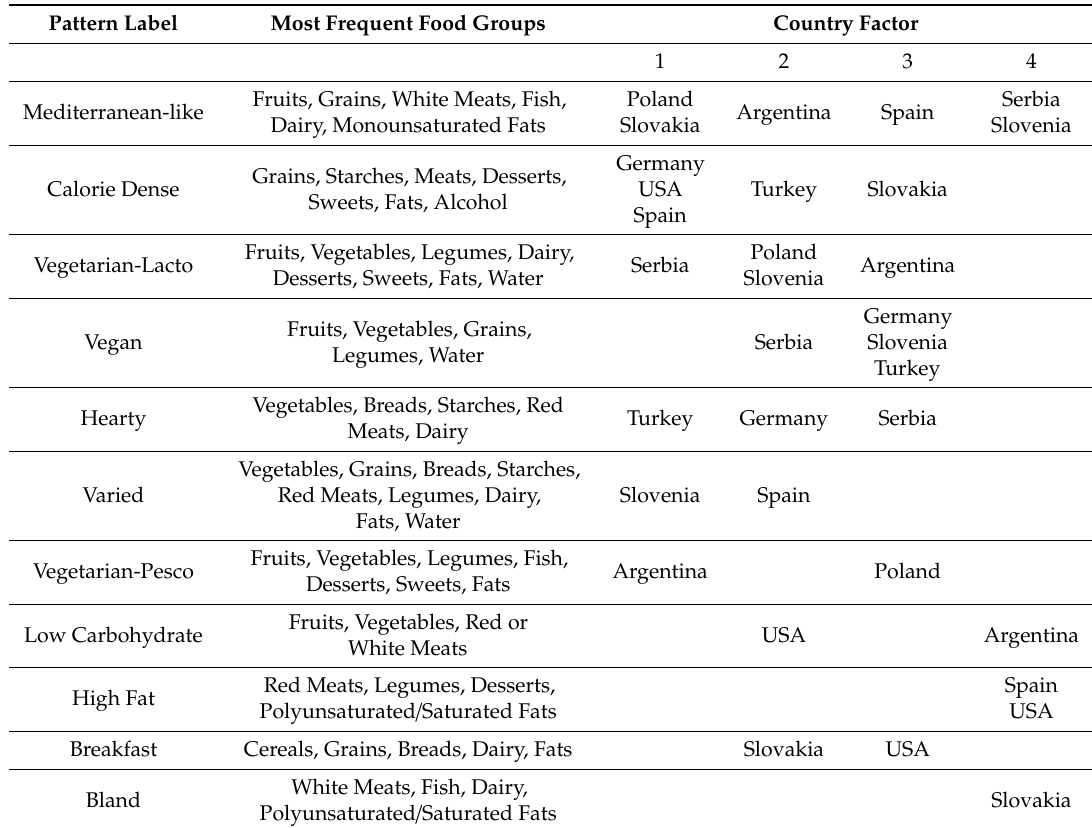
Table 3. Food Group Definitions of Dietary Pattern Labels Assigned to the Factors and Countries Identified by